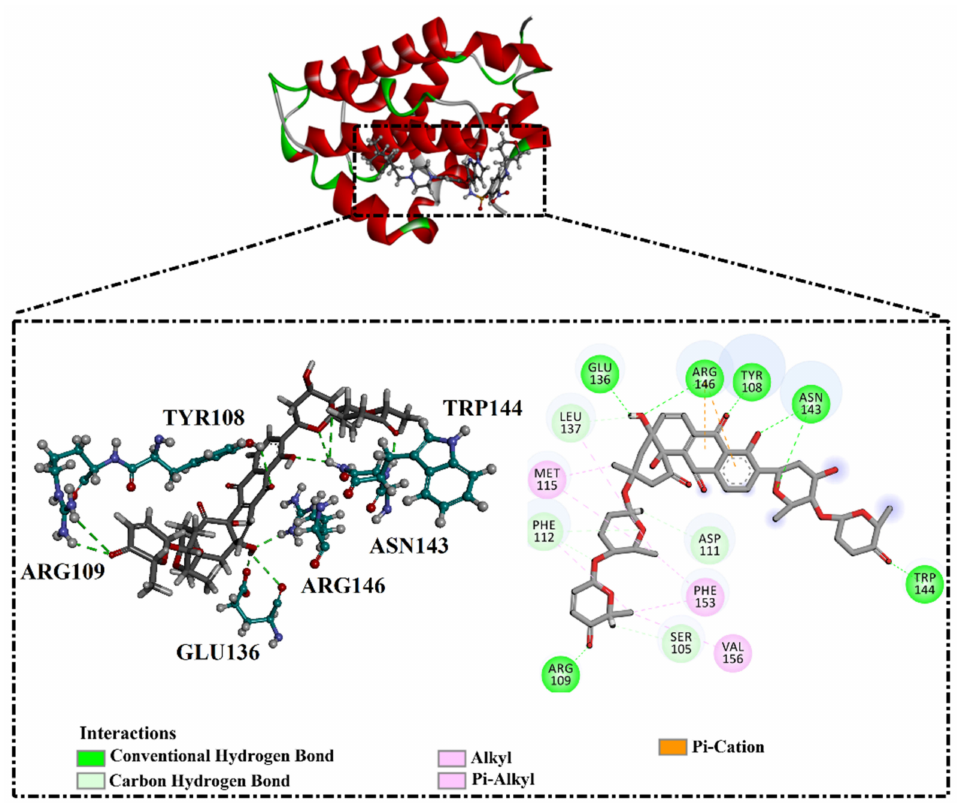
Figure 2. The three- and two-dimensional molecular interactions of saquayamycin F (NPA002200) complexed with the Bcl-2